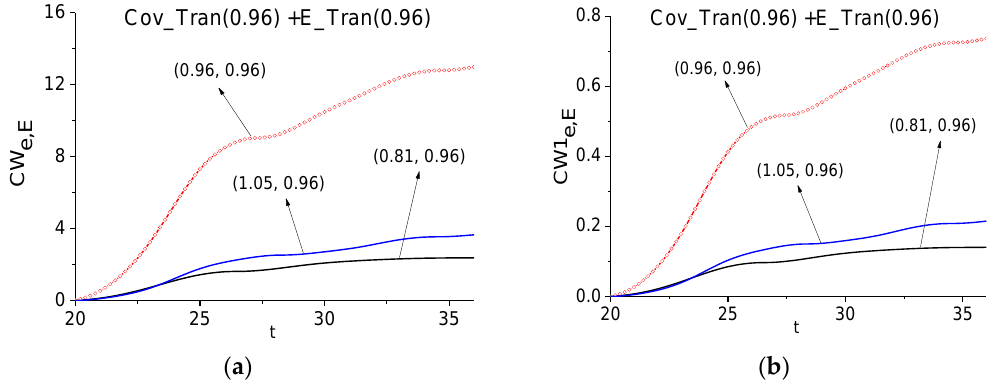
Figure 9. Time-dependent ICC CW e,E ( a ), CW1 e,E ( b ) calculated at the frequency ν = 0.96 in the time interval t = [20, 36] for the pair of pulses transmitted through the medium with covering (Cov_Tran—a signal under investigation) and without covering (E_Tran—a standard signal).